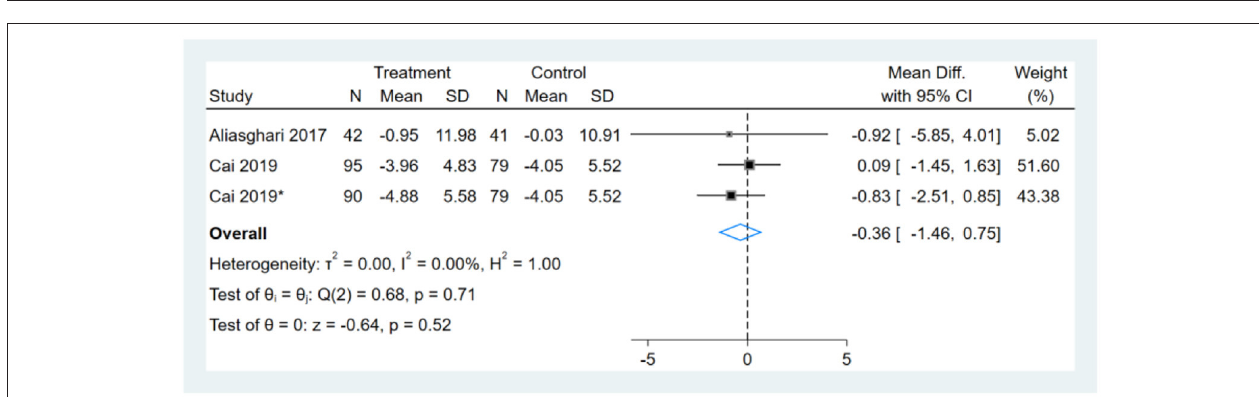
FIGURE 3 | Forest plot analysis showing changes in body mass index (BMI). *This study has two fasting intervention groups.